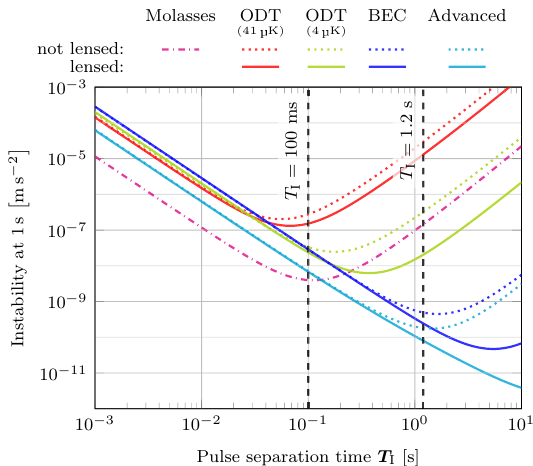
Fig. 4 Instability comparison. Behavior of the instability for shot-noise limited atom interferometers after an integration time of τ = 1 s for different sources (Tab. 1) over the pulse separation time T I . The instability is estimated for molasses cooled ensembles, thermal ensembles released from the optical dipole trap (ODT), and Bose-Einstein condensates (BEC and Advanced) also released from the optical dipole trap. The colors of the curves, except for the molasses and advanced case, agree with the measurements displayed in Fig. 2. The different source parameters are described in more detail in the “ Methods ”